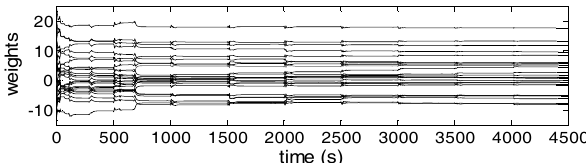
Figure 4. Q-NN output weights in Q-function learning of VRFT control